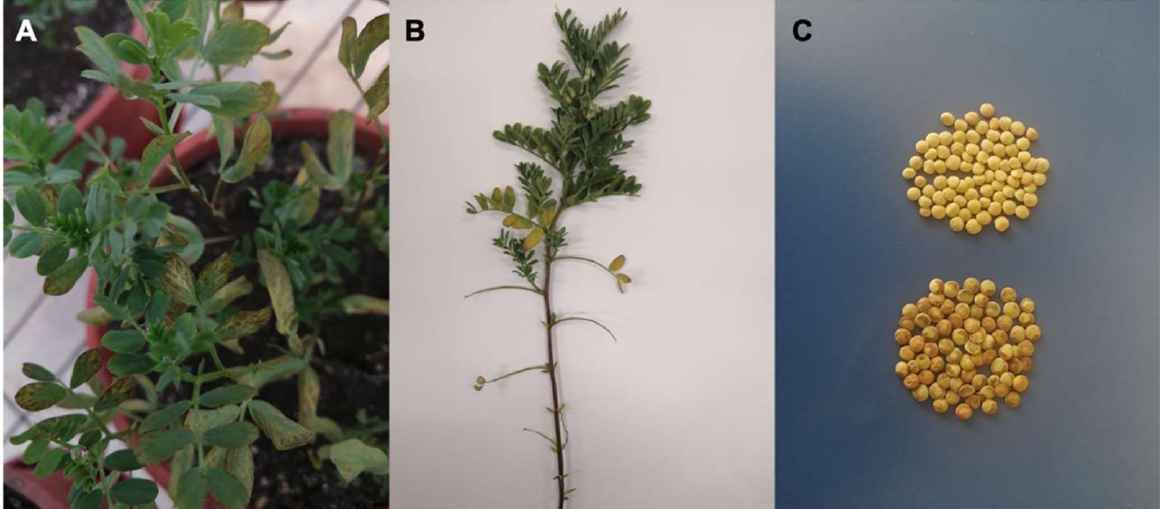
Figure 6. Lentil plants grown in pots with toxicity symptoms of Fe and Mn toxicities. ( A ) Brown and black spots in basal leaves and normal young leaves at the tip without symptomatology. ( B ) Complete defoliation of basal leaves and chlorotic progression in remanent leaves showing symptomatology of Fe and Mn toxicities. ( C ) Normal healthy lentil seeds (above) and spotted seeds with high Fe and Mn concentrations